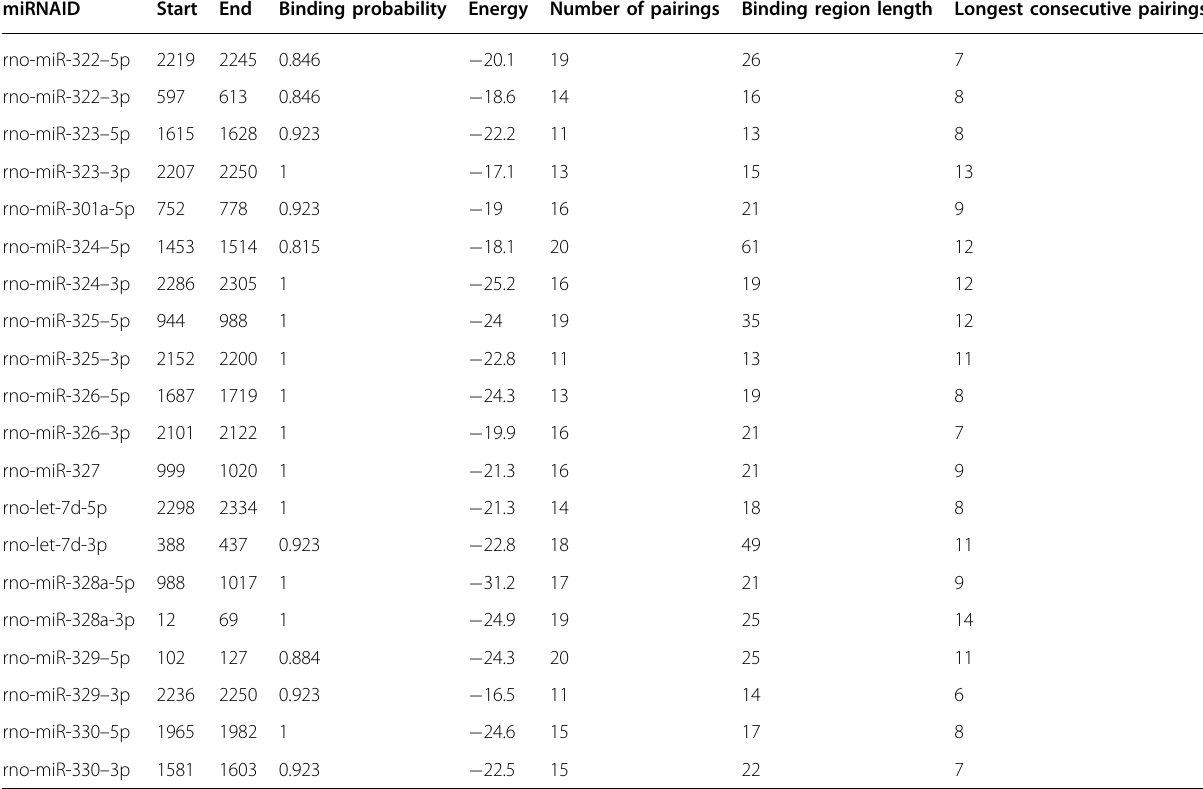
Table 2 Top 20 miRs regulating FAM13A